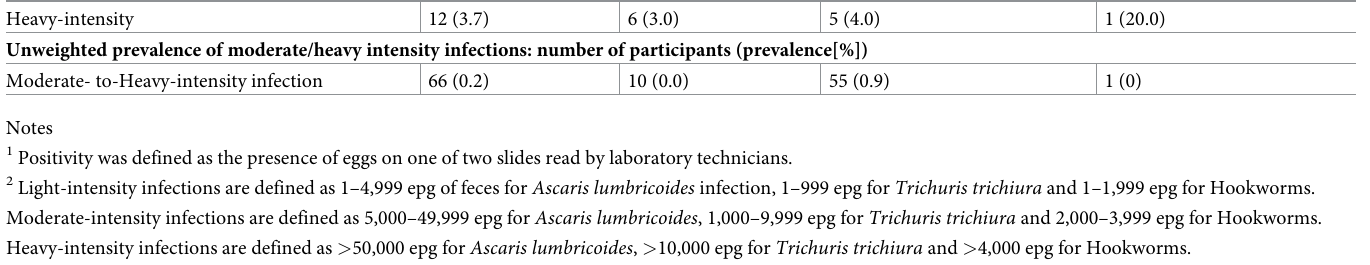
chiura infections, only the analyses focused on hookworm and Ascaris lumbricoides are pre- sented. Among all infections, 258 (79.7%) were light-intensity, 54 (16.7%) were moderate- intensity and 12 (3.7%) were heavy intensity infections. Hookworm was significantly more prevalent in adults than in SAC or PSAC (4.4% versus 2% versus 1% respectively, Chi 2 , p < 0.001). SAC were significantly more infected with Ascaris lumbricoides compared to PSAC